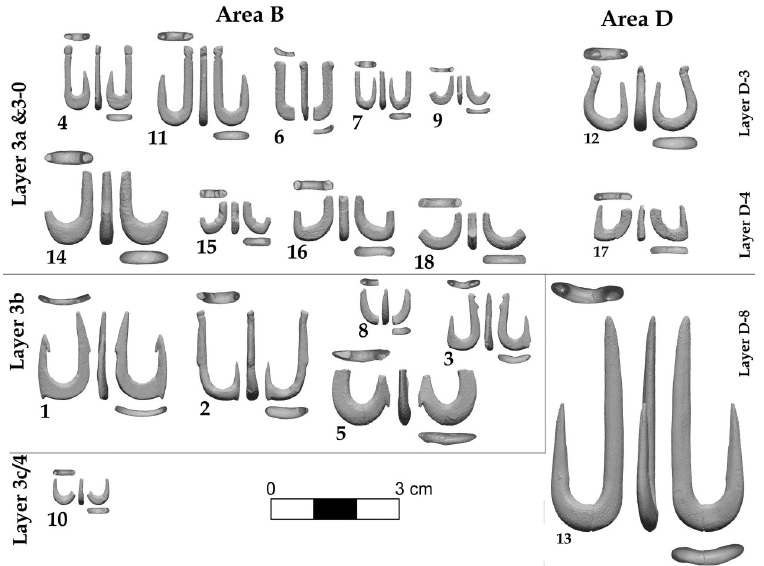
Fig 4. Images of all JRD bone fish hooks obtained from 3D models, arranged by